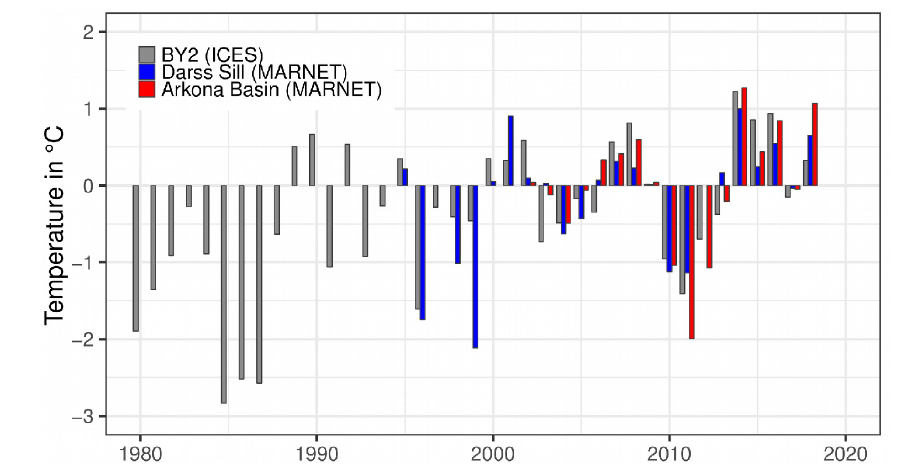
Figure 20. Annual mean sea surface temperature anomalies, with respect to the reference period of 2002–2018, of deseasonalised measure- ments at the monitoring station BY2 (for the location, see Fig. 2) and the MARNET stations (Darss Sill and Arkona Basin) during 1980–2018. Data source: Oceanographic Data Center at the Federal Maritime and Hydrographic Agency (dod@bsh.de).